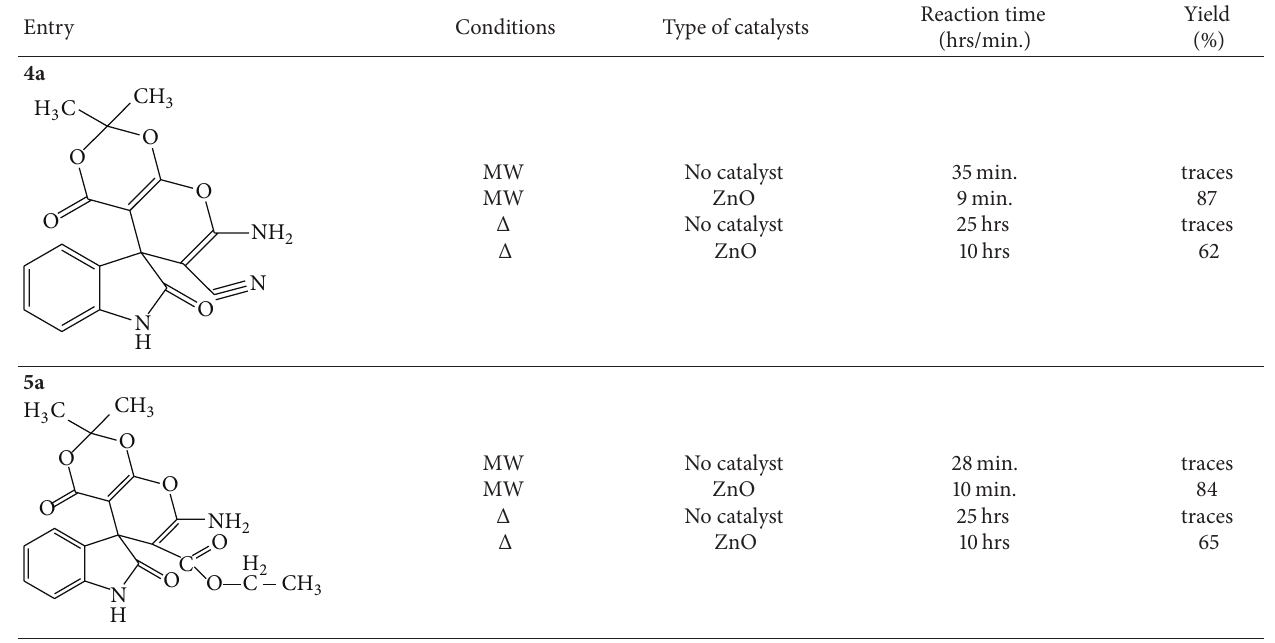
Table 2: Comparison of catalytic activity of ZnO nanoparticles in the synthesis of compounds 4 a and 5 a by conventional heating (Δ) and microwave irradiation method